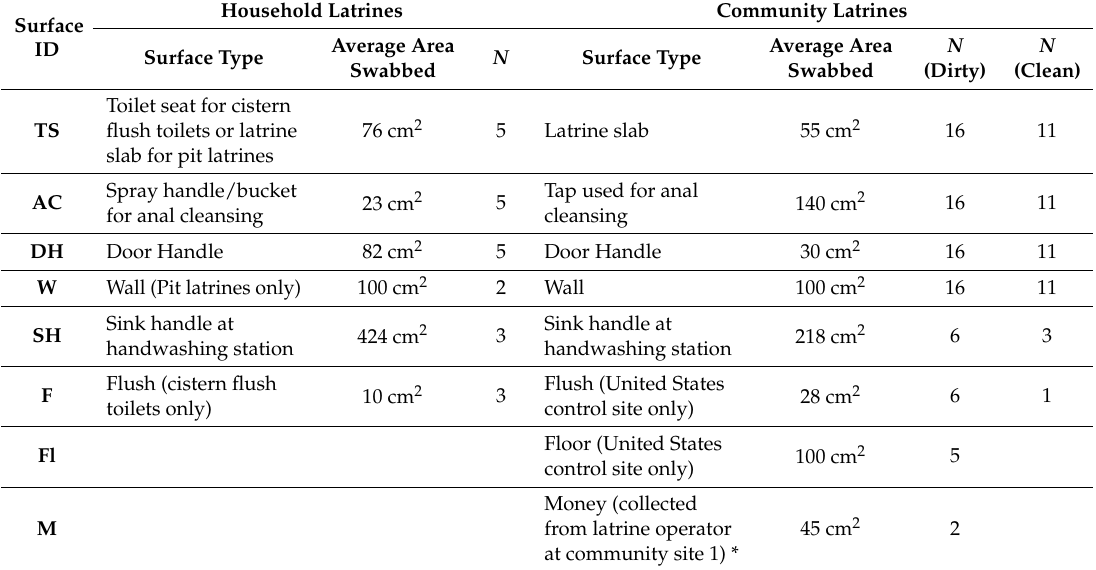
Table 1. Description of surfaces